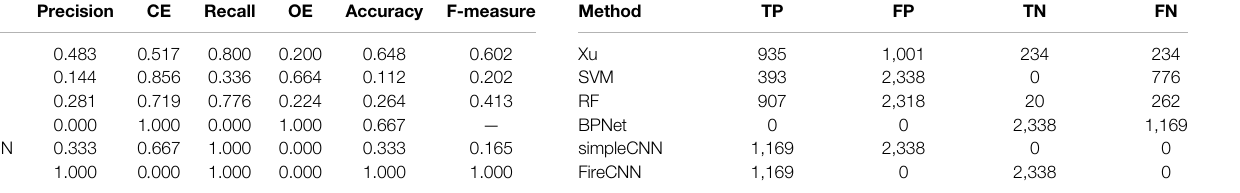
TABLE 2 | Comparison of fi ve models, including the proposed FireCNN. Method